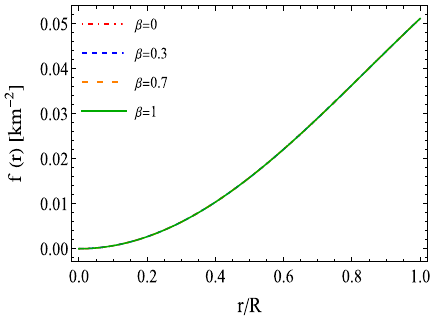
Fig. 5 The behavior of the deformation function versus radial coordi- nate r / R for the solution 4.2 corresponding to the case ˆ Y TF = Y TF